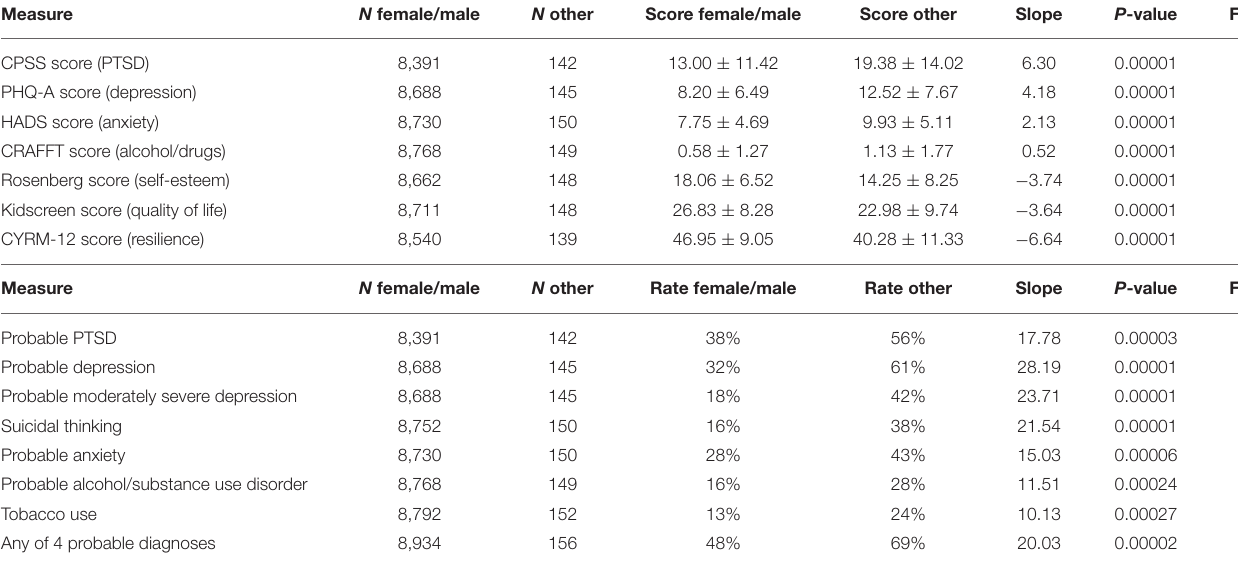
Table shows participant numbers, summary statistics, and results of analysis of effects of other vs. female/male gender identity. N X columns indicate number of participants identifying as gender X (other or female/male). Score X columns show mean ± standard deviation (not standard error) for gender X. Rate X columns indicate rates of probable diagnosis for gender X. Slope is the fitted slope parameter from a linear model with time and age partialled out (see discussion of nuisance variables in the Materials and Methods). The slope parameter indicates the linear relationship between the other vs. female/male effect variable and the dependent variable, independent of time and age. P-values were derived from permutation testing on the slope parameters. Comparisons with an asterisk under the FDR column survived FDR multiple comparison correction. P-threshold for FDR correction was